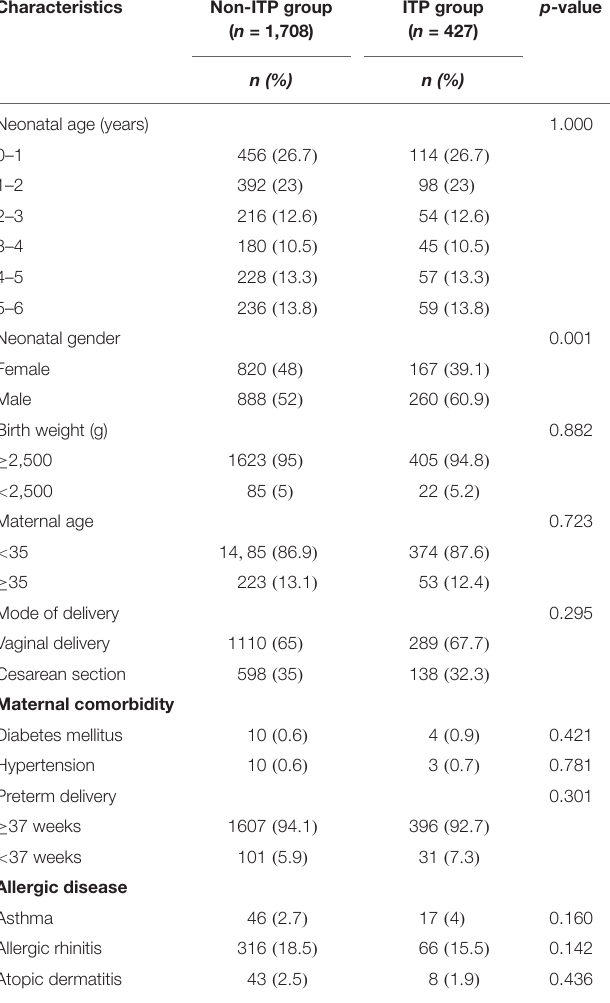
matched control group.